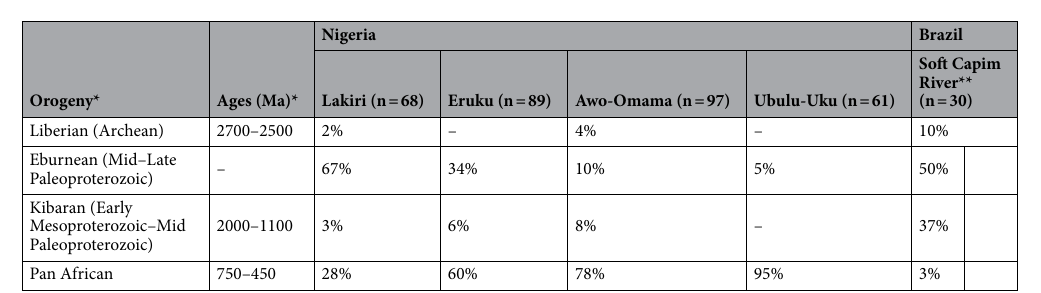
Figure 9. U–Pb concordia diagram of detrital zircon grains ( a ) Ages < 1300 Ma, ( b ) Ages > 1300 Ma, and ( c ) probability density diagram of detrital zircon ages with concordance between 90 and 110% in the studied Ubulu-Uku kaolins.